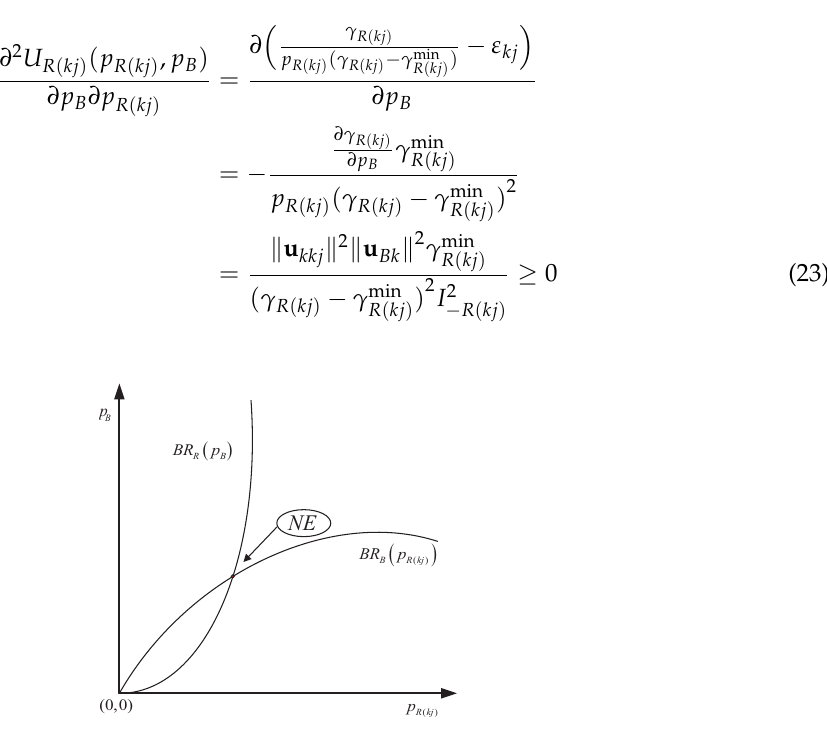
Figure 2. Nash equilibrium for supermodular power allocation game